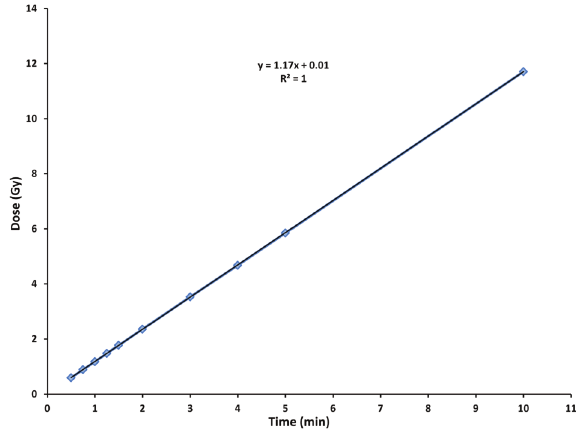
Figure 3. Irradiator linearity in the 0.5 to 10 min range.